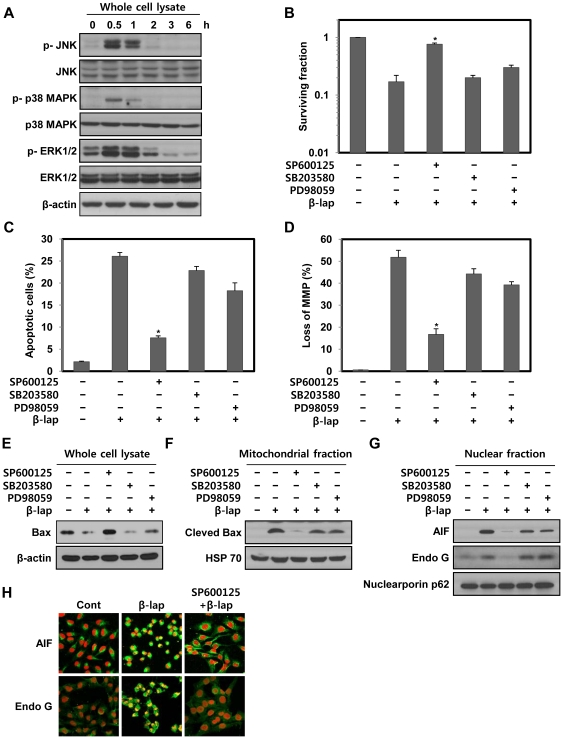
β-lap activates MAPKs in NQO1+-MDA-MB-231 cells.(A) NQO1+-MDA-MB-231 cells were treated with 5 µM of β-lap for the indicated times. Cell lysates were subjected to Western blot analysis with anti-phospho-ERK1/2, -ERK1/2, -phospho-JNK1/2, -JNK1/2, -phsopho-p38 MAPK, -p38 MAPK and β-actin antibodies. β-actin was used as a loading control. The data represent a typical experiment conducted three times with similar results. (B) NQO1+-MDA-MB-231 cells were treated with 5 µM of β-lap in the presence or absence of PD98059 (30 µM), SP600125 (30 µM) or SB203580 (30 µM). Cells were allowed to grow for 10 to 14 days and were stained with 0.5% crystal violet and scored for colony formation. Results from three independent experiments are expressed as means ± SEM. *Significant difference between cells in the presence or absence of SP600125 after β-lap treatment, at p<0.05. (C) NQO1+-MDA-MB-231 cells were treated with 5 µM of β-lap for 18 h in the presence or absence of PD98059 (30 µM), SP600125 (30 µM) or SB203580 (30 µM). Cells were stained with PI and the percentage of cells with a sub-G1 DNA content was measured via flow cytometric analysis. Results from three independent experiments are expressed as the means ± SEM. *Significant difference between the cells in the presence or absence of SP600125 after β-lap treatment at p<0.05. (D) NQO1+-MDA-MB-231 cells were treated with 5 µM of β-lap for 6 h in the presence or absence of PD98059 (30 µM), SP600125 (30 µM) or SB203580 (30 µM). Cells were loaded with 30 nM of DiOC6(3) for a further 30 min of the treatments. After removal of medium, the concentration of retained DiOC6(3) was measured by flow cytometry. Results from three independent experiments are expressed as means ± SEMs. *Significant difference between the cells in the presence or absence of SP600125 after β-lap treatment at p<0.05. (E) NQO1+-MDA-MB-231 cells were treated with 5 µM of β-lap for 6 h in the presence or absence of PD98059 (30 µM), SP600125 (30 µM) or SB203580 (30 µM). Cell lysates were subjected to Western blot analysis using anti-Bax, -Bcl-2 and -β-actin antibodies. β-actin was used as a loading control. The data represent a typical experiment conducted three times with similar results. (F) NQO1+-MDA-MB-231 cells were treated with 5 µM of β-lap for 6 h in the presence or absence of PD98059 (30 µM), SP600125 (30 µM) or SB203580 (30 µM). Mitochondrial fractions were prepared and subjected to Western blot analysis using anti-Bax and -mitochondrial HSP70 antibodies. Mitochondrial HSP70 was used as a mitochondrial marker protein. The data are representative a typical experiment conducted three times. (G) NQO1+-MDA-MB-231 cells were treated with 5 µM of β-lap for 6 h in the presence or absence of PD98059 (30 µM), SP600125 (30 µM) or SB203580 (30 µM). Nuclear fractions were prepared and subjected to Western blot analysis using anti-AIF, -Endo G, and -Nucleoporin p62 antibodies. Nucleoporin p62 was used as a nuclear marker protein. The data are representative a typical experiment conducted three times. The data are representative of a typical experiment conducted three times with similar results. (H) Representative confocal images showing translocation of AIF and Endo G to the nucleus, and nuclear condensation, at the indicated times after treatment with 5 µM of β-lap for 6 h in the presence or absence of SP600125 (30 µM). Nuclear translocation of AIF and Endo G is demonstrated by overlap of AIF or Endo G (green) and nuclear staining (red), resulting in a yellow color. The data are representative of a typical experiment conducted three times.